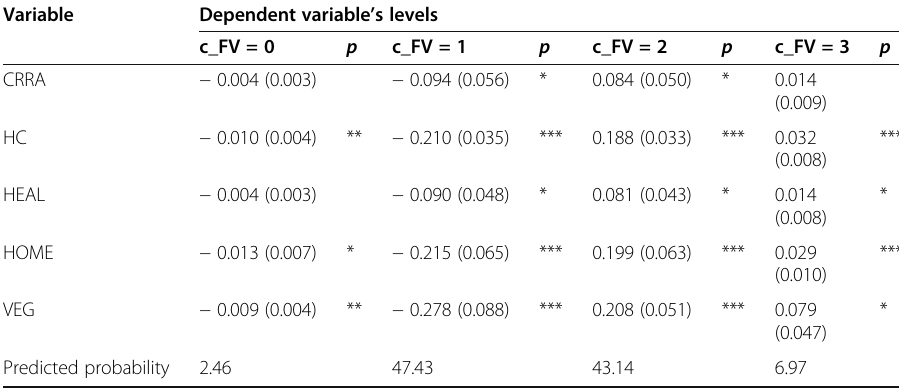
Table 7 Marginal effects from the estimated ordered logit